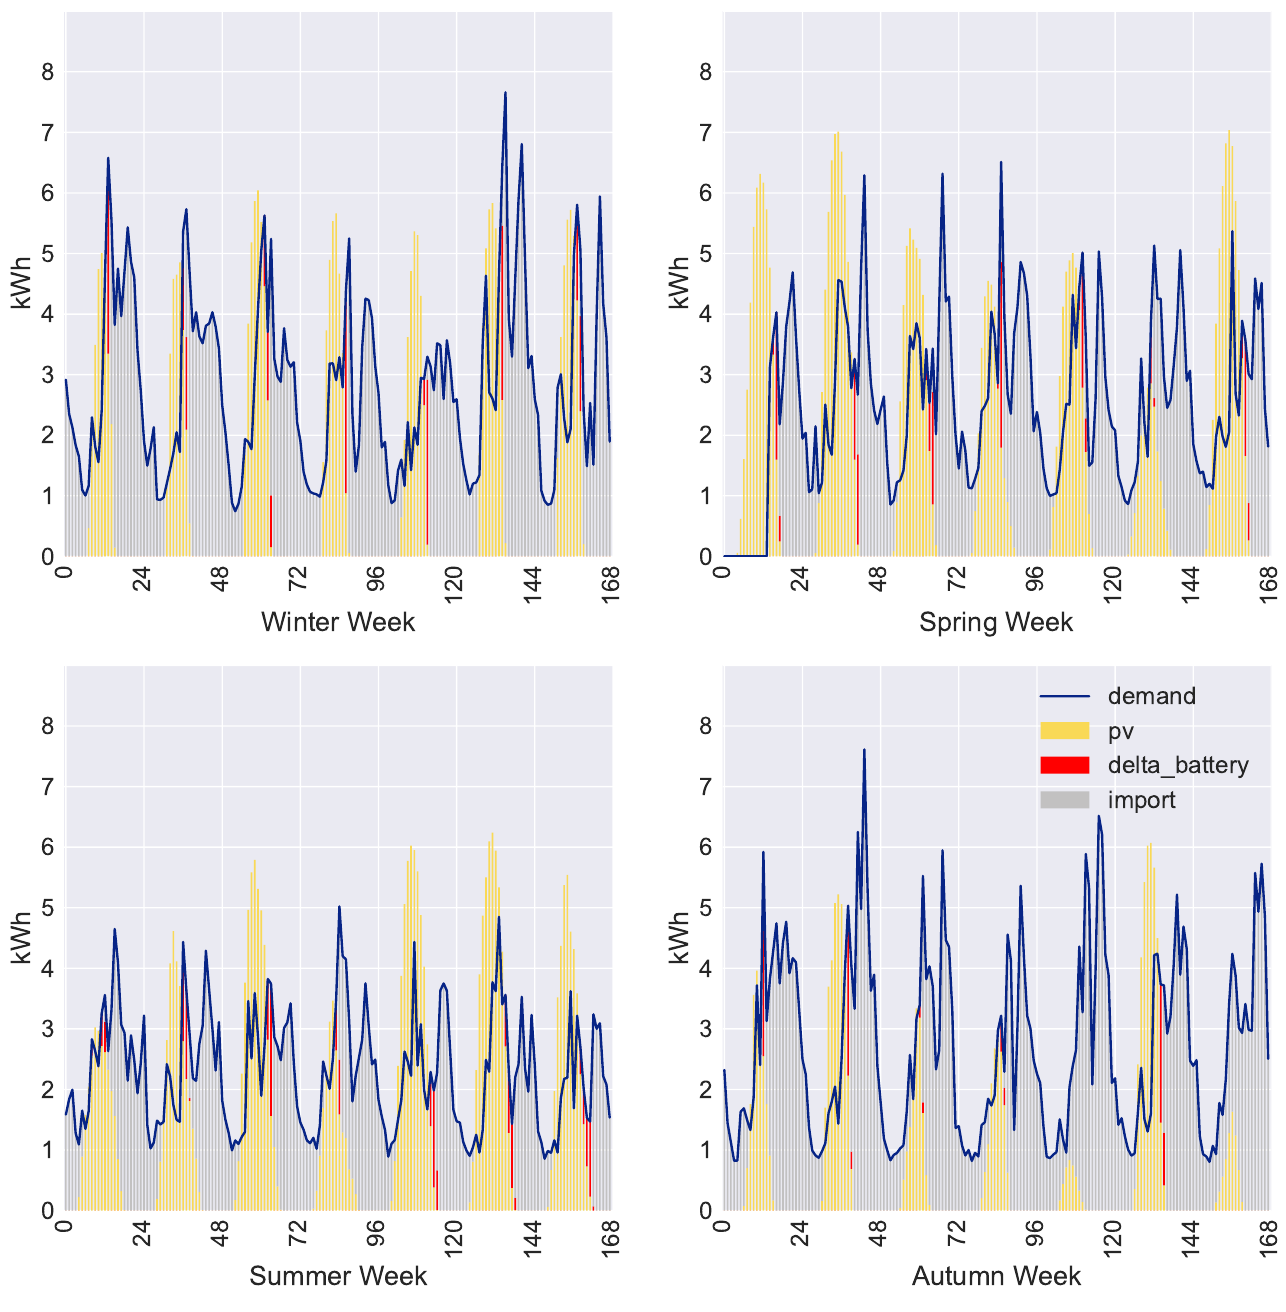
Figure A6. Weekly electricity production per technology source: Location